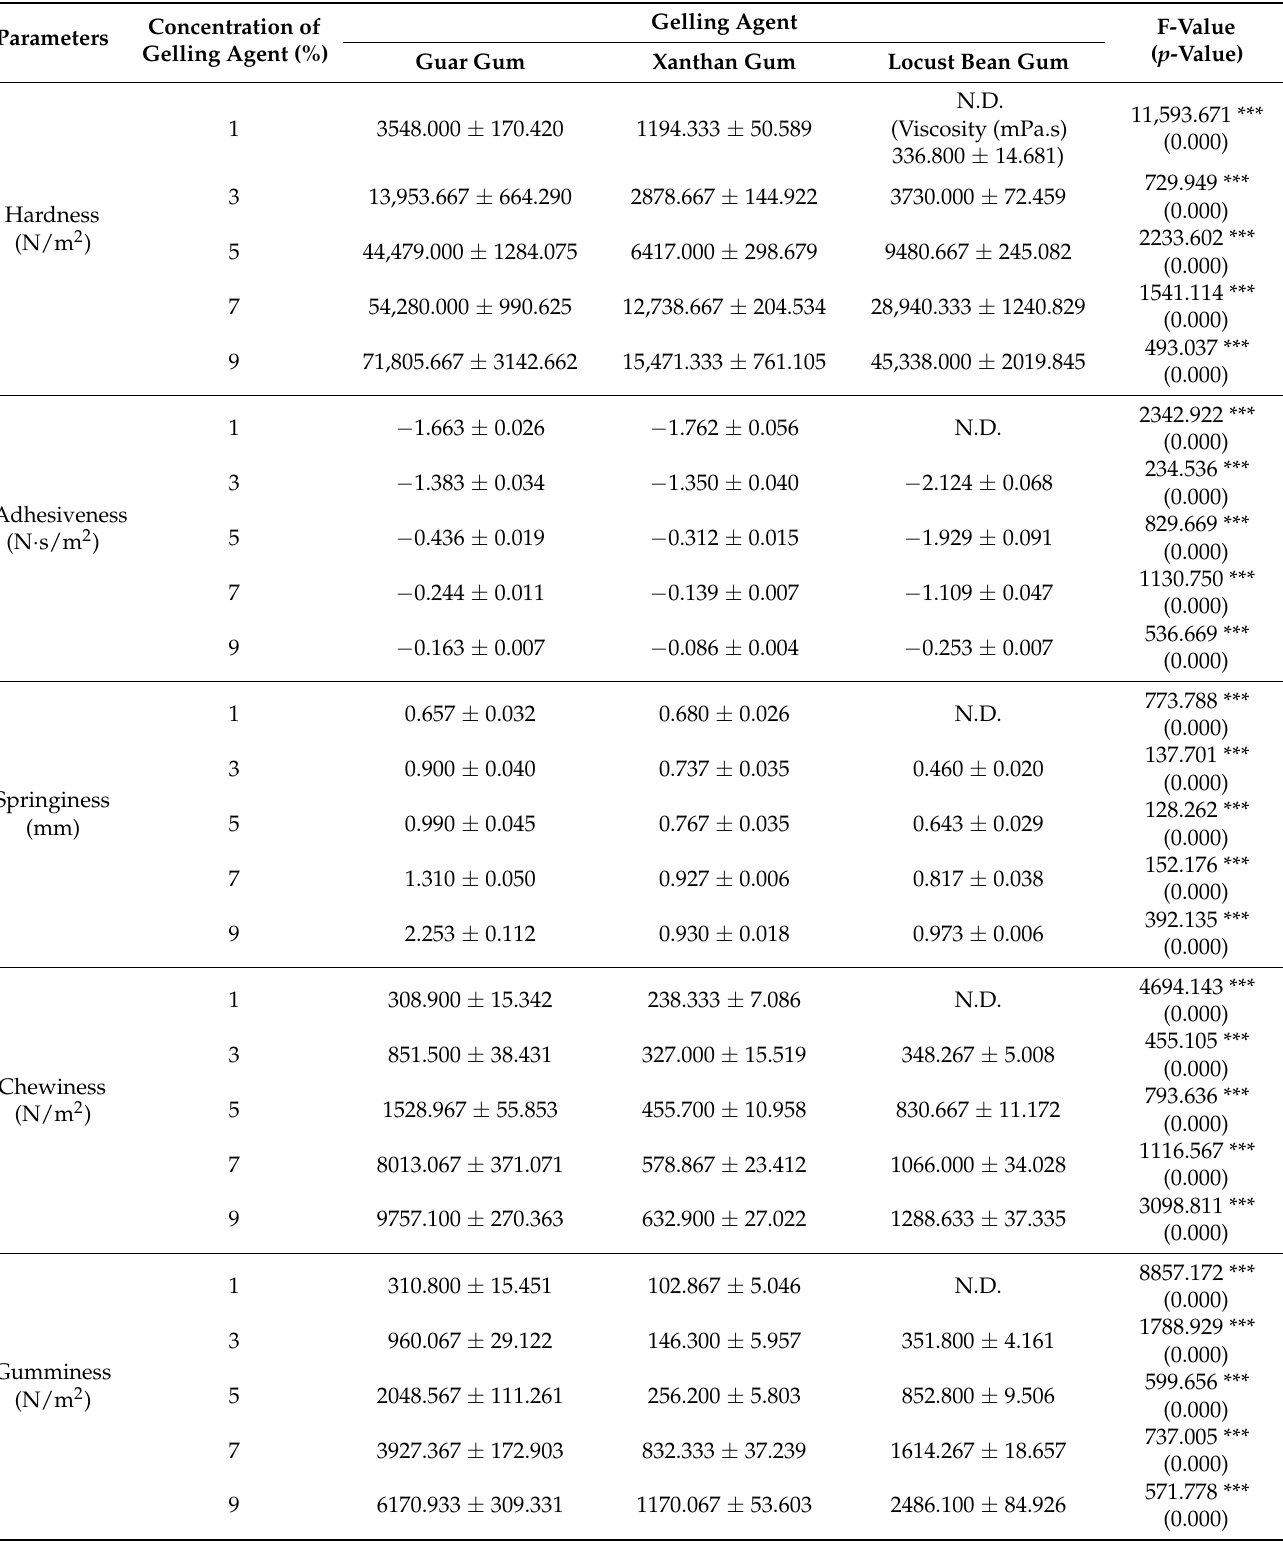
Table 4. Texture of sea buckthorn jelly added with gelling